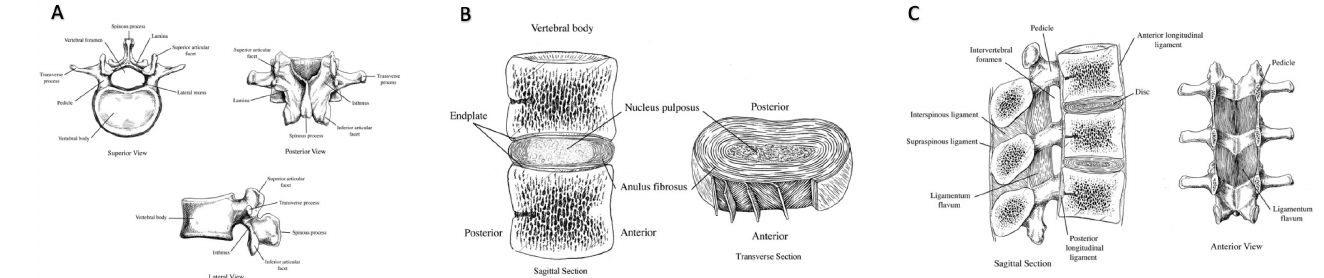
Figure 1. Anatomy of the Lumbar Spine. ( A ) Superior, posterior and lateral aspect of the lumbar vertebrae and the associated osseous structures. ( B ) The sagittal and transverse cross-sections of the lumbar intervertebral disc and its three component parts—the nucleus pulposus, annulus fibrosus, and endplate. ( C ) The sagittal and anterior aspect of the articulating lumbar vertebrae—note the intervertebral foramen formed between the pedicles of the neighboring vertebrae [9]. Adapted from Ebraheim et al. [9].